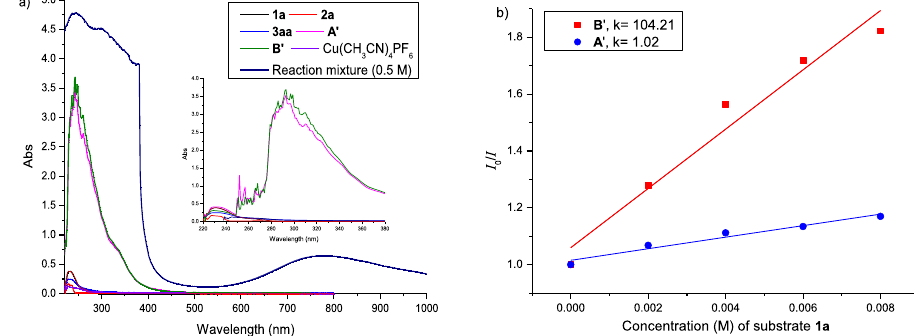
Fig. 4 Spectroscopic studies. a UV-Vis spectra of 1a , 2a , 3aa , A ’ , B ’ and Cu(NCCH 3 ) 4 PF 6 in DCM (5 × 10 − 5 M) and reaction mixture in EtOH ( 1a , 0.5 M). b , Stern – Volmer quenching ef fi ciency of 1a with A ’ and B ’ (5 × 10 − 5 M in DCM, λ ex = 344